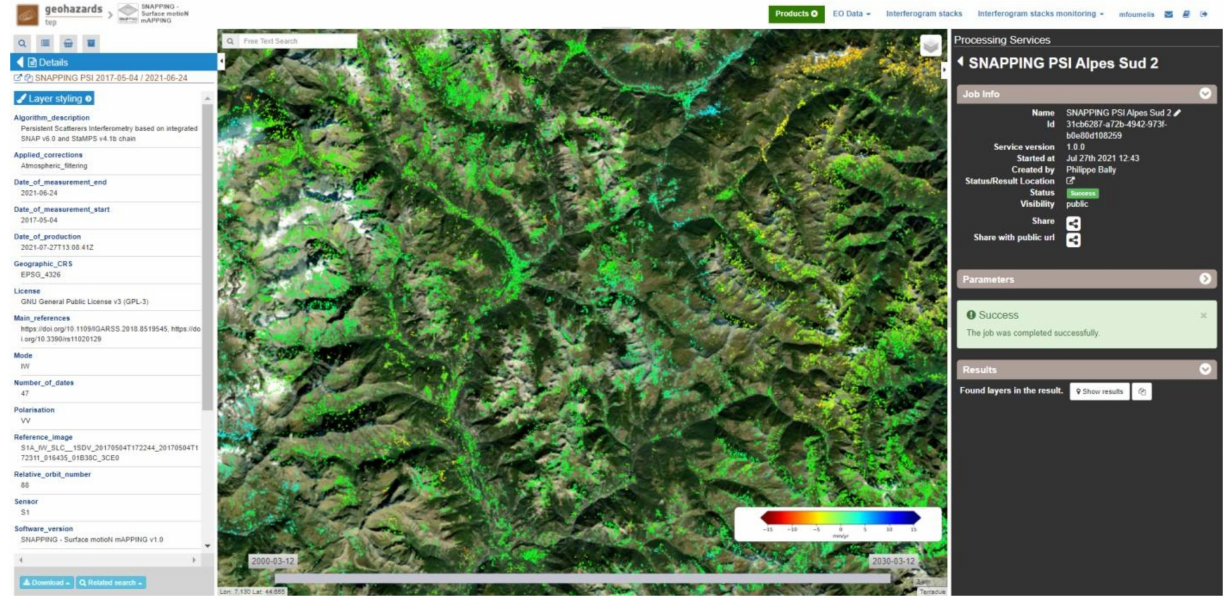
Figure 4. The GEP geobrowser interface for visualization of successful jobs and download of corresponding products. Contains modified Copernicus Sentinel-1 data (2017–2021), processed by ESA on